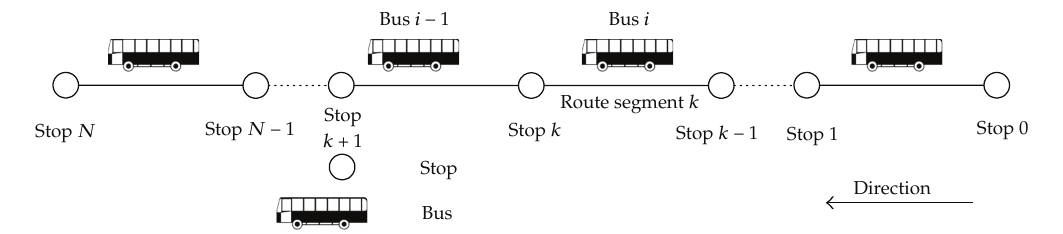
Figure 1: Example bus